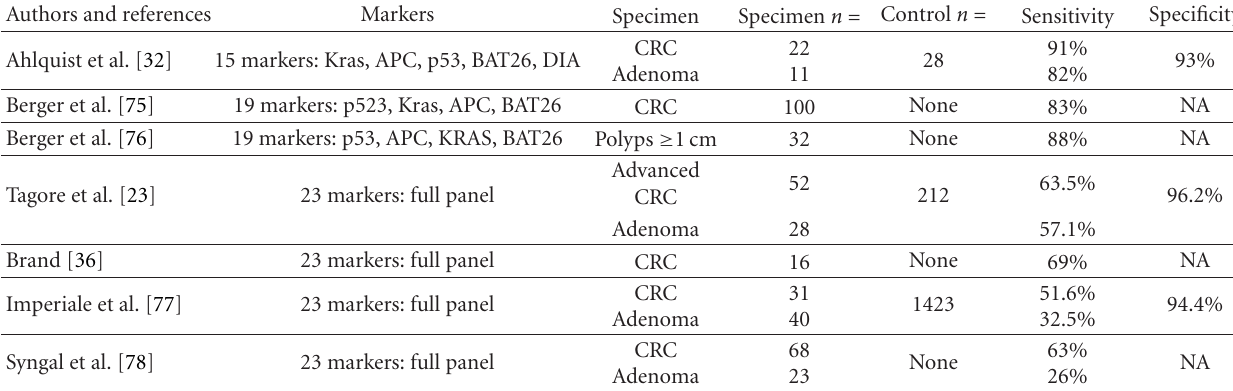
Table 3: Studies of the PreGen panel in the detection of genetic alterations in fecal